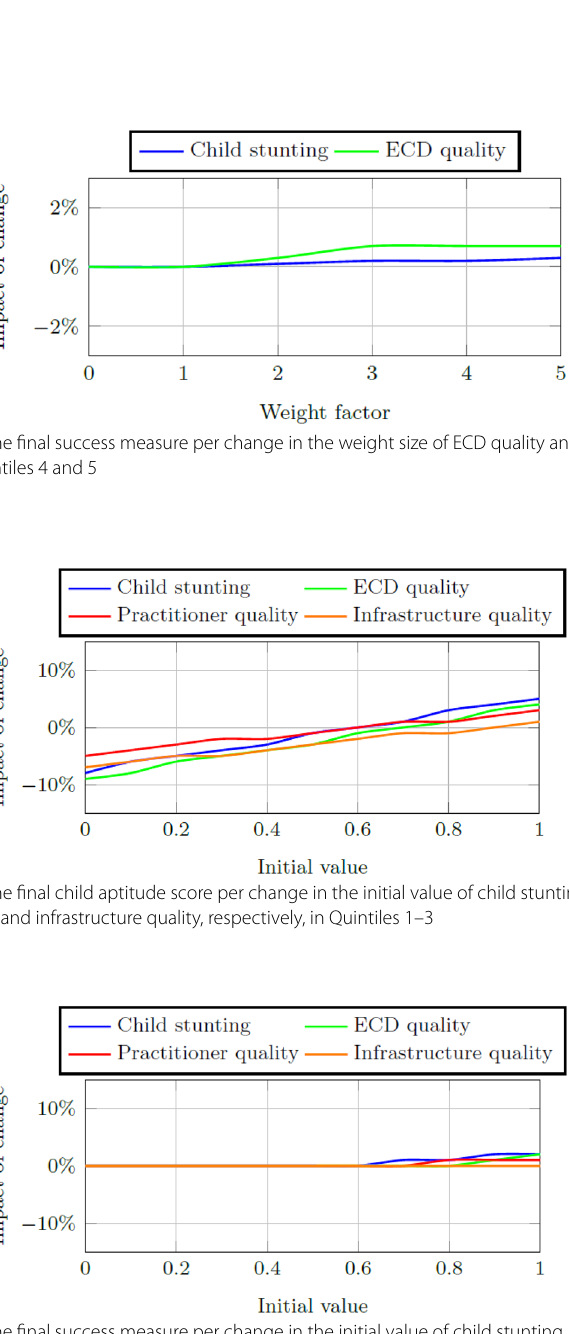
Fig. 9 Impact on the final success measure per change in the initial value of child stunting, ECD